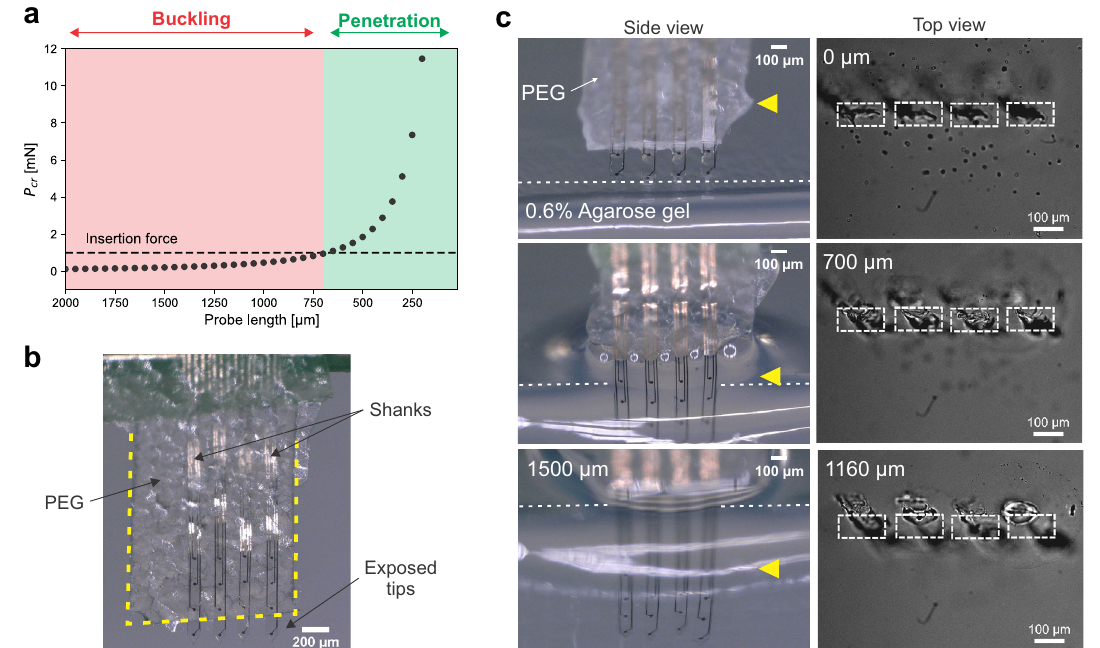
Figure 2. Tissue-friendly insertion system by reducing the effective length. ( a ) Buckling force threshold P cr as a function of probe length for the PaC based shanks with width of 100 μm, thickness of 10 μm and a Young’s modulus of 2.76 GPa 30 . The minimum insertion force of 1 mN needs to be withstand by the probe for penetration of the tissue. ( b ) Array with a PEG coating (boarded in yellow) leaving the first 200 μm from the tip exposed to temporally reduce the effective shank length. ( c ) Series of optical images showing the